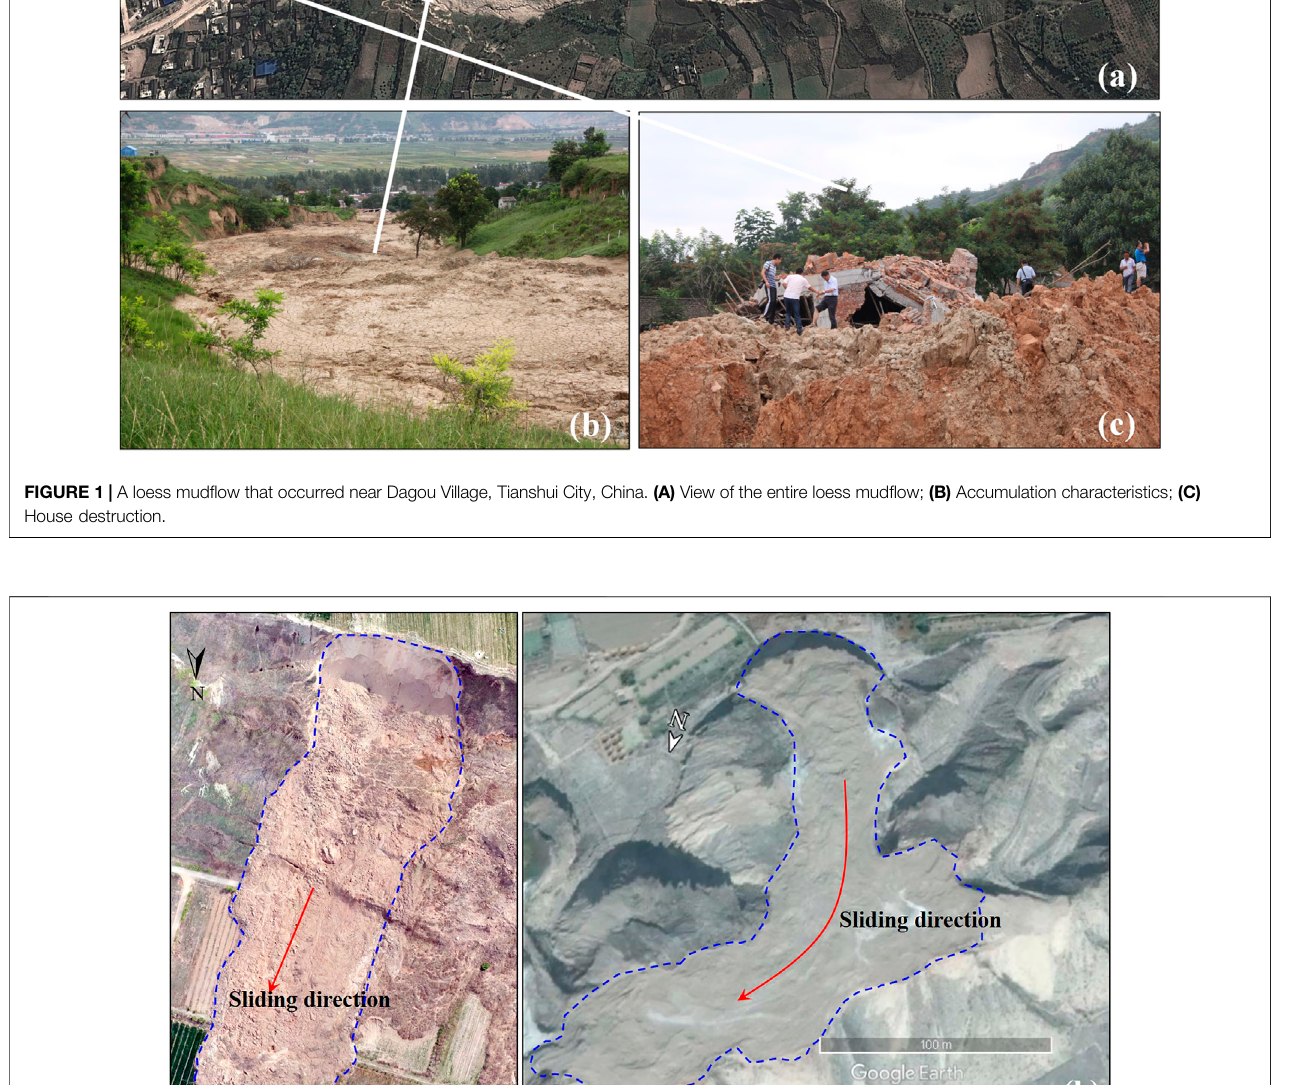
produced by the Tianjin Aoyou Xingtong Company, China, with a measuring range of 0 – 50 kPa. The speci fi c layout of the soil sensors is shown in Figure 4 .